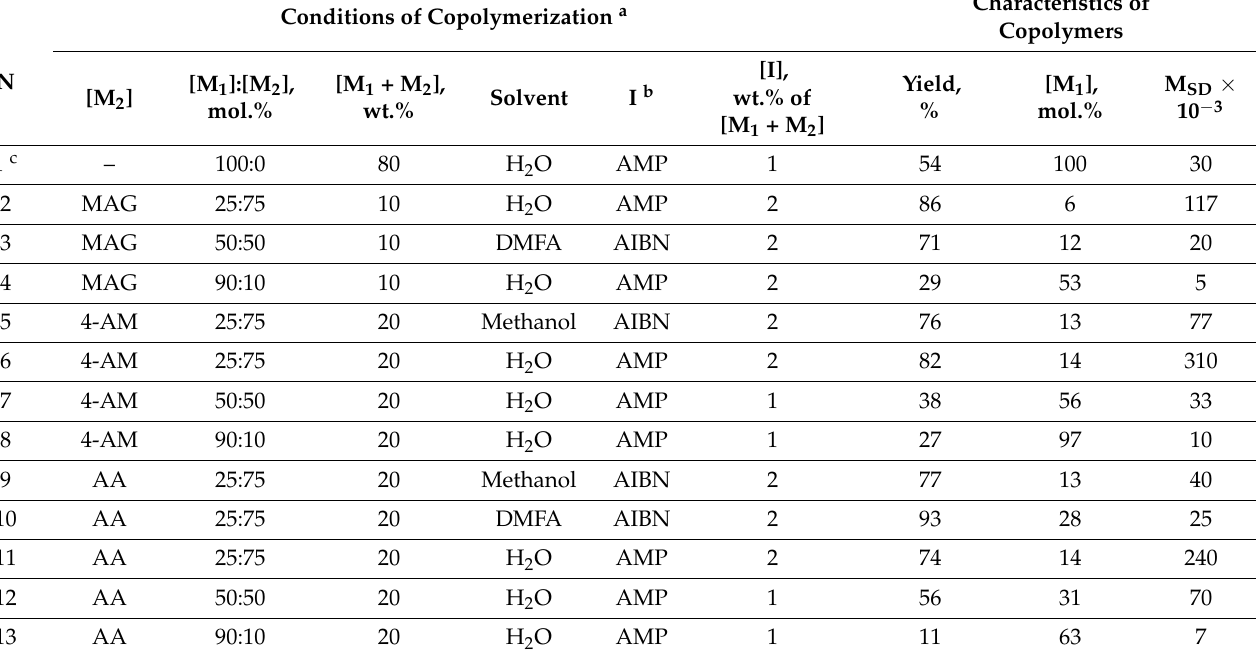
Table 1. Synthesis conditions and characteristics of VPA copolymers (M 1 ).